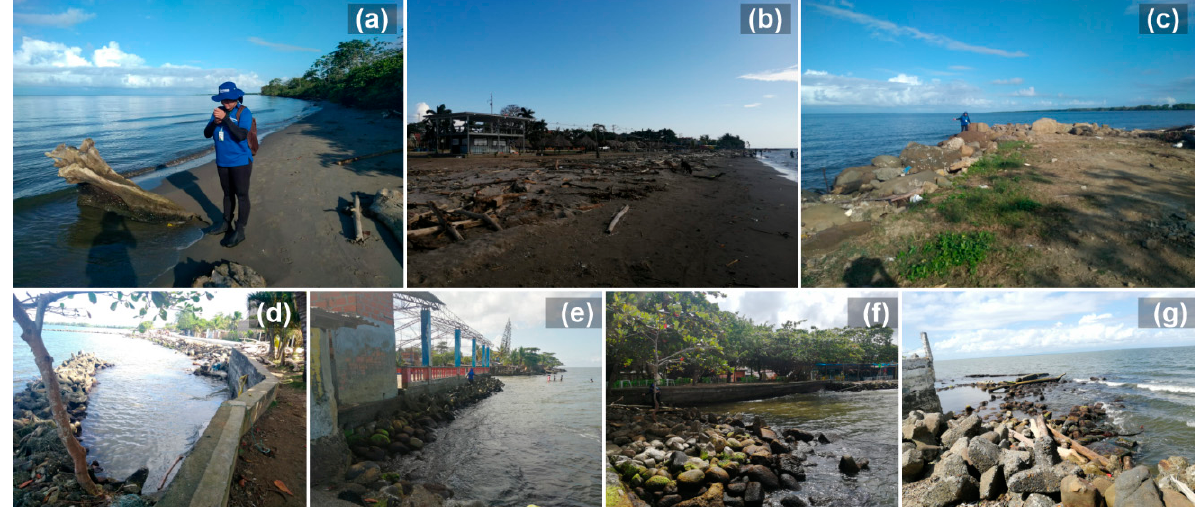
Figure 3. Beach and coastal protection structures in the study area: ( a ) Segment 1; ( b ) Segment 2; ( c ) Segment 3; ( d ) Segment 4; ( e ) Segment 5; ( f ) Segment 6; ( e ) Segment 7.